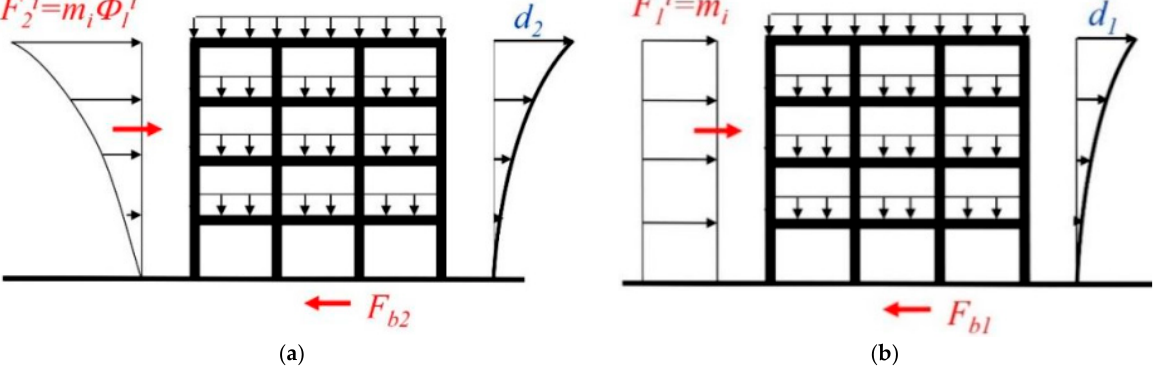
Figure 10. Schematic loading configurations for PO analyses: ( a ) first mode proportional distribution (MS type) and ( b ) uniform distribution (UAS type).